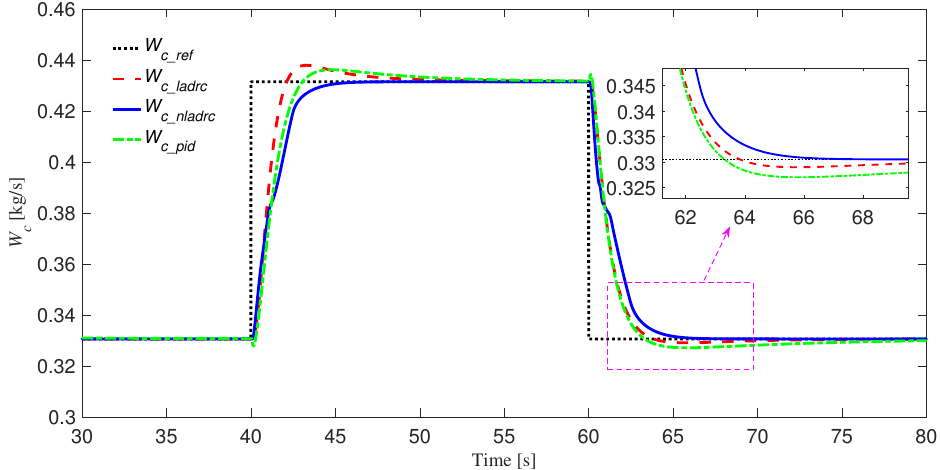
Figure 5. Response curve of mass air flow W c